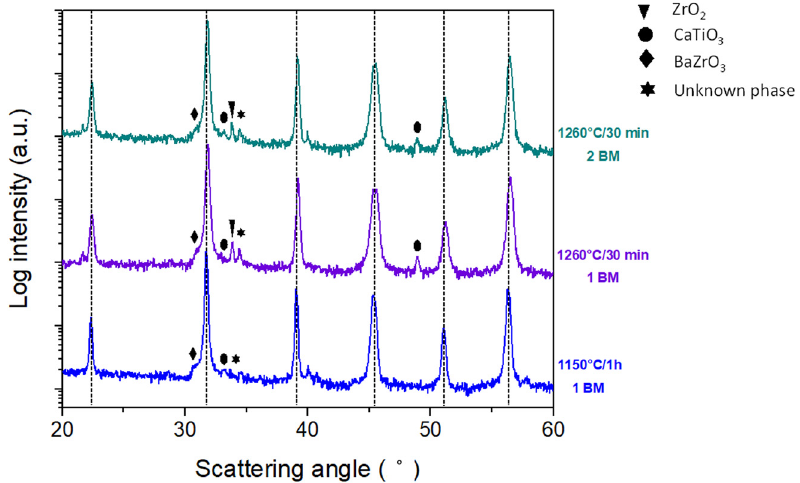
Figure 4. XRD diffraction patterns of the sintered ceramics, after synthesis at 700 °C for 30 min, at different sintering times and temperatures using a single sintering plateau, with and without a sec- ond ball milling treatment after synthesis (2 BM and 1 BM, respectively). Vertical dotted lines indi- cate the main BCZT perovskite reflections.